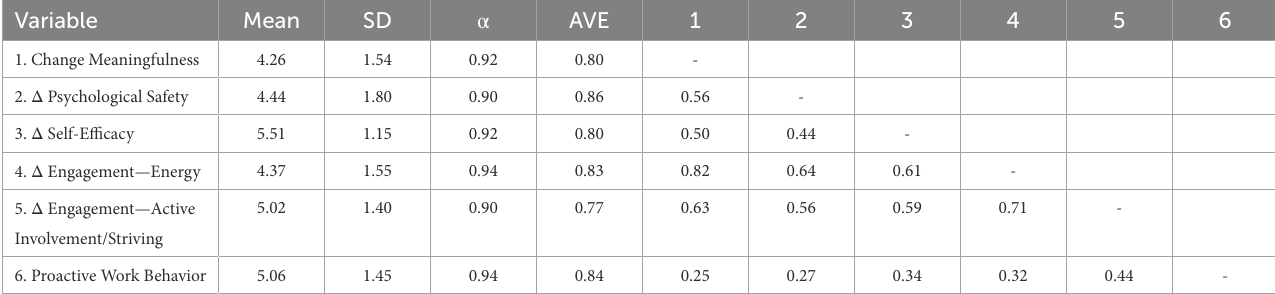
TABLE 3 Means, SD, Cronbach’s alpha ( α ), average variance extracted (AVE), and correlations among first-order variables ( N = 297).